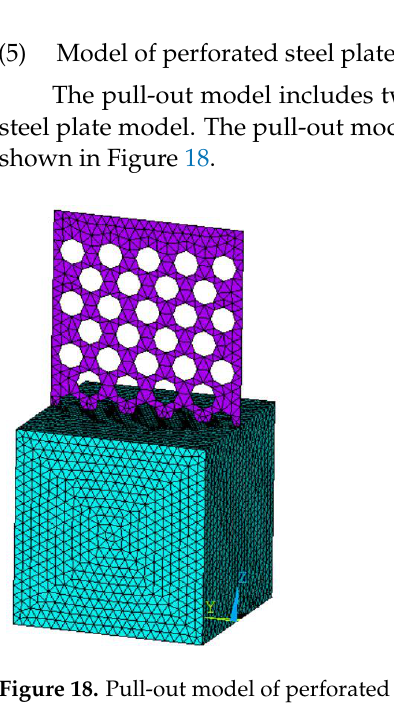
Figure 18. Pull-out model of perforated steel plate reinforced concrete.